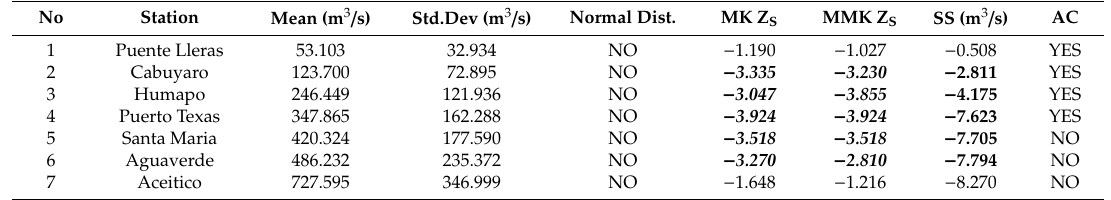
Table 4. Summary of annual minimum streamflow trend test using MK and SS in the Meta River.